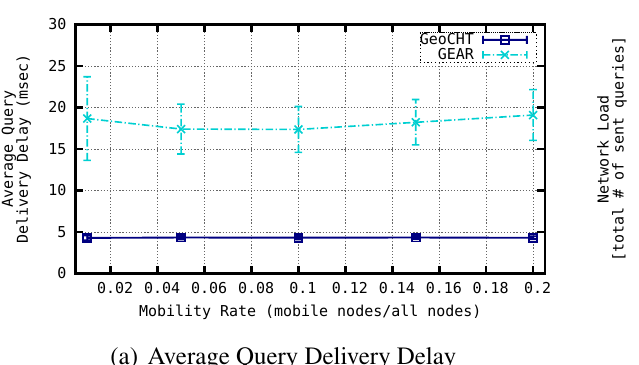
Figure 9. Networking performance with varying mobility